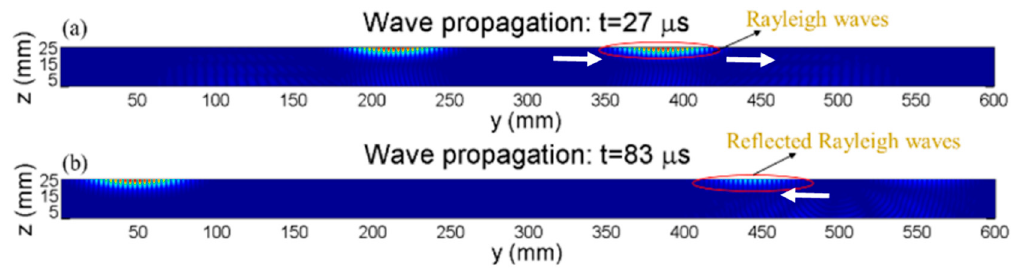
Figure 7. Wave propagations. ( a ) and ( b ) denote the velocity fields at 27 µs and 83 µs, respectively. Reproduced with permission from [15], IEEE, 2016.